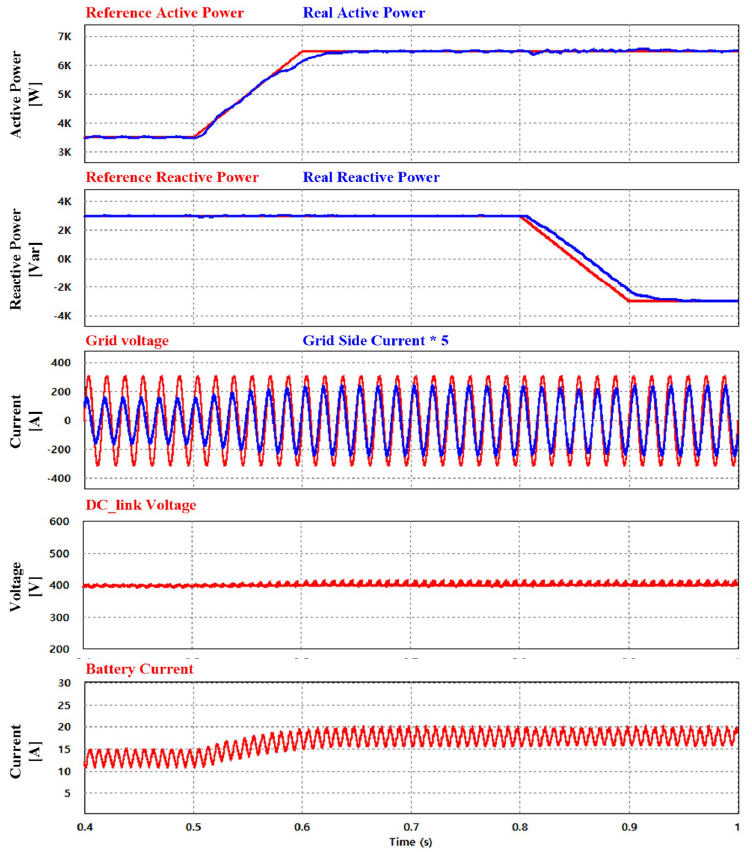
Figure 8. Simulation results of active and reactive power flow control method.